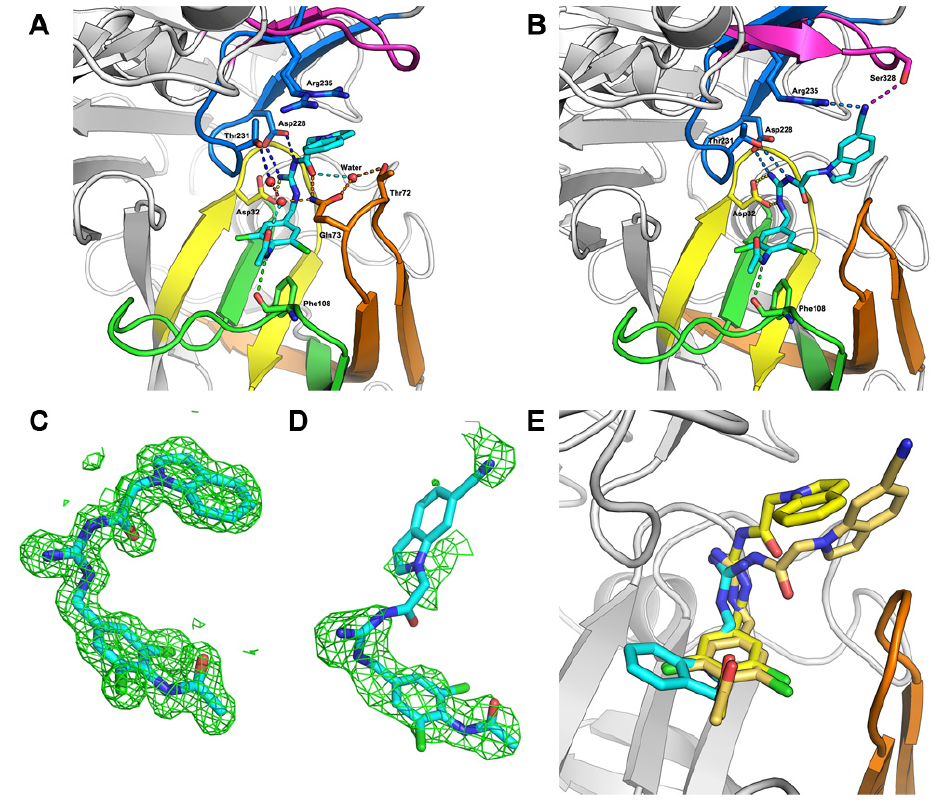
Figure 3. The structures of BACE1 in complex with compounds. ( A – B ) Cartoon representation of the crystal structure of BACE1 in complex with compounds 19 ( A ) and 25 ( B ). The pdb codes for generating figures A and B are 4IVT and 4IVS, respectively. The key residues and ligands 19 and 25 are highlighted with sticks. ( C – D ) ( F difference electron-density maps contoured at 2.0  for compounds 19 ( C ) and 25 ( D ). ( E ) The superimposition of the structures of BACE1 in complex with the compounds 19 , 25 and the docked fragment. Three small molecules were shown with